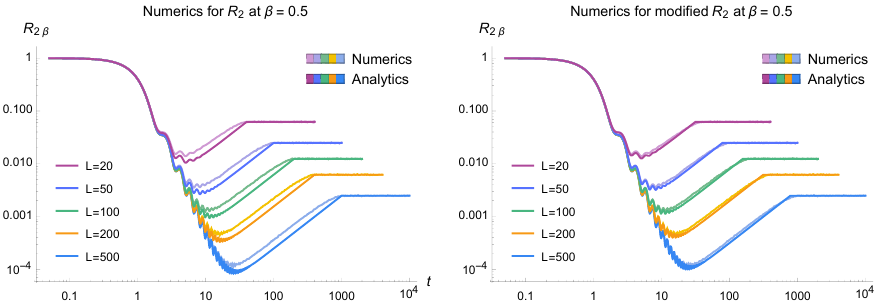
Figure 11 . Numerical checks of the (cid:12)nite temperature 2-point spectral form factor for GUE at (cid:12) = 0 : 5, plotted for various values of L and normalized by their initial values. Numerics were done with a GUE sample size of 10000. The left (cid:12)gure uses the expression for R 2 ( t; (cid:12) ) derived in section 2.2 and C.1, whereas the right (cid:12)gure uses the modi(cid:12)ed ramp ~ r 2 discussed above.